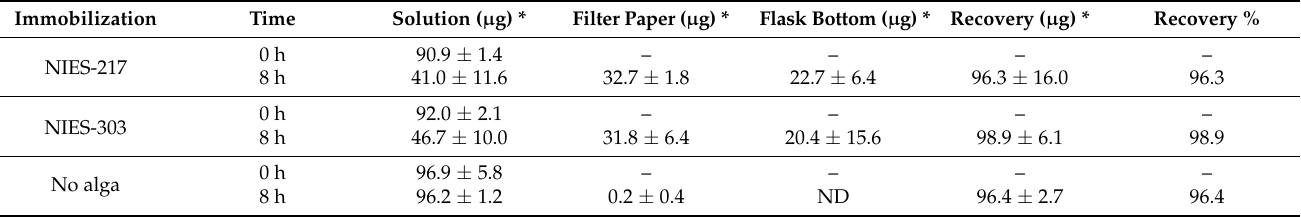
Table 2. Removal and recovery of Pb by the immobilized cells at 0 h and after soaking for 8 h. Immobilization